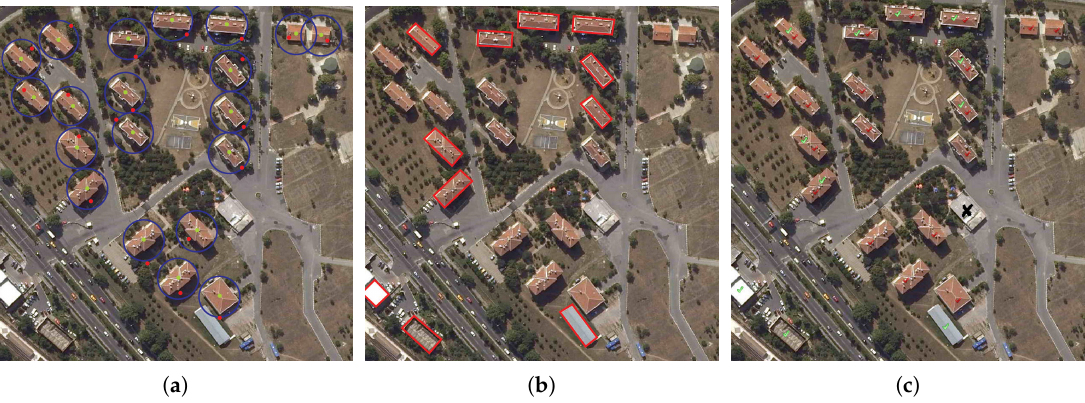
Figure 9. Figure 9a–c show the resultant output of applying TBD, FBD, and results fusion, respectively, on the Ist10 study area. Table 9. Accuracy assessment of applying BDSV on Ist10, including 24 building